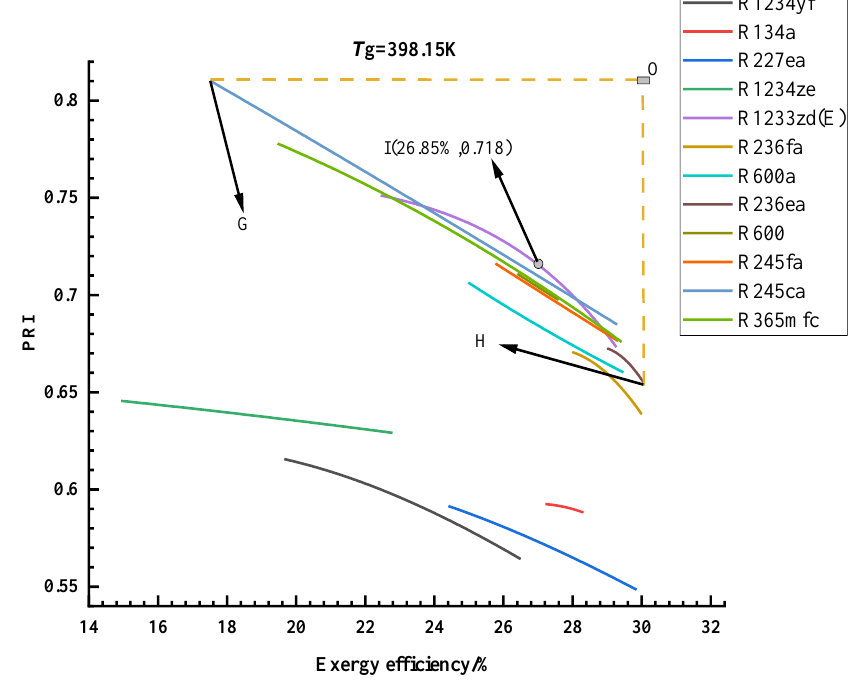
Figure 11. Optimized results of SS/CS under the heat source temperature of 398.15 K. The above method can be used to analyze the working conditions with the heat source temperatures of 373.15 and 423.15 K, and the results show that when the heat source temperature is 373.15 K, the optimal working mediums corresponding to SS, CS, and SS/CS are, respectively: R245ca (38.99%, 0.178), R245fa (20.38%, 0.242), and R365mfc (15.80%, 0.468). When the heat source temperature reaches 423.15 K, the optimal working